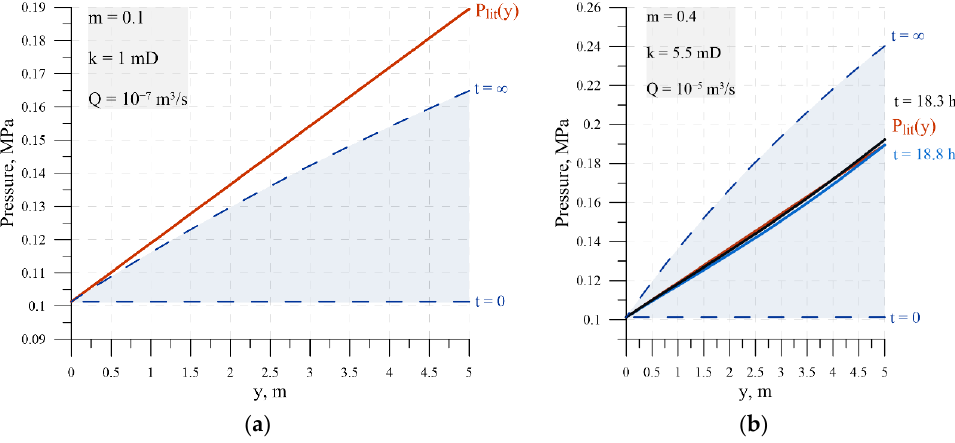
Figure 4. Gas pressure along the gas conduit at any time ( a ) or 18.8 h and 18.3 h ( b ) after 𝑡 (cid:2868) . The time required for the gas pressure to reach the critical value depends on the gas flow rate and properties of the material at different depths (Figure 5). Correspondingly, three scenarios of rock failure (gas blowout) are possible: it may start at the base or at the top of the gas channel, or synchronously all along the channel; or it may never occur. Figure 5. Flow rate dependence of the failure onset. 4. Laboratory Experiment Laboratory modeling of gas flow was performed using a system of the type of Hele- Shaw cell (Figure 6), with two vertically oriented plane-parallel glass panels 0.7 mm apart. The space between the panels was filled with glass balls 0.2–0.3 mm in diameter, to a height of 20 cm above the cell bottom. The spacing between the panels was large enough to accommodate a double-packed layer of balls. The required density of the ball pack (1.75 g/cm 3 ) was achieved by vibration compaction of balls poured in small batches. The cell base (1) had a hole (2) for gas supply from a gas balloon (3), and the cell top was open to air (4). Gas pressure was measured with a transducer (5) connected to an ADC (6), gas flow rate was measured with a float-type meter (7), and changes in the ma- terial structure were recorded with a video camera (8).